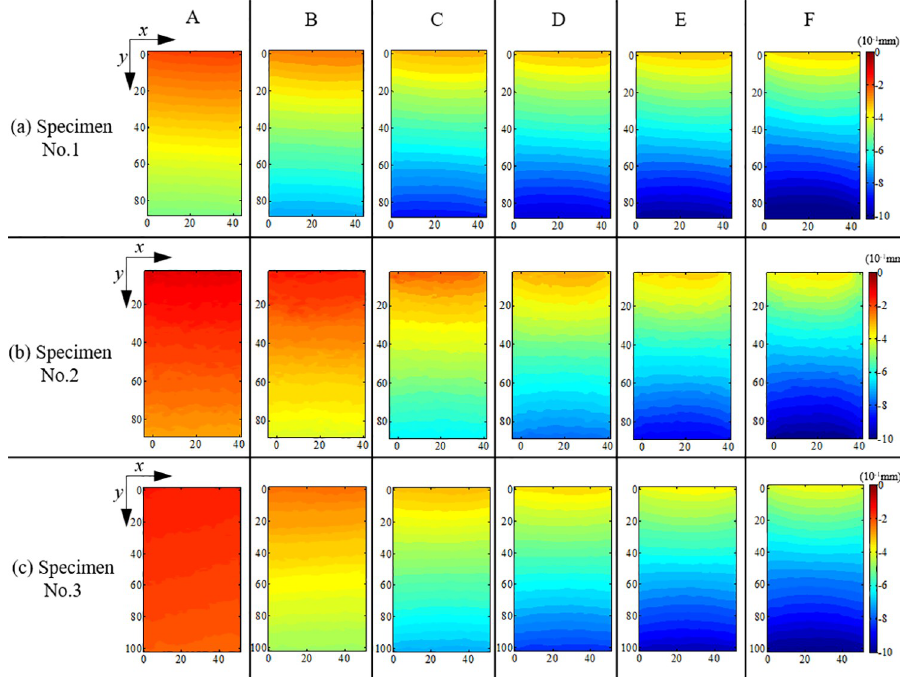
Fig 5. Vertical displacement-field ( u y ) for (a) Specimen No. 1; (b) Specimen No. 2; (c) Specimen No.